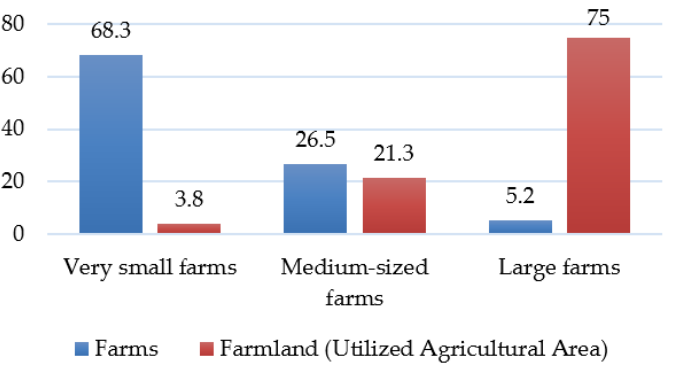
Figure 6. Farms and agricultural land in accordance with the size of farms in standard output (SO) as a percentage in 2016. Source: Eurostat (online data code: ef_m_farmleg) [28]. Note: very small farms: SO of <EUR 8000; medium-sized farms: SO of EUR 8000 to EUR 249,999; large farms: SO of >EUR 250,000.